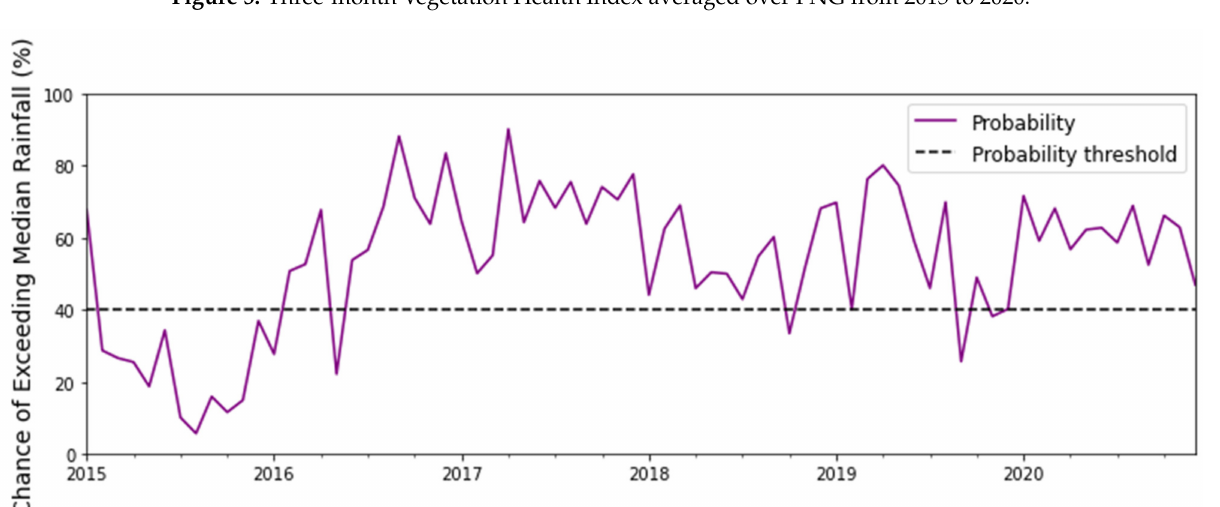
Figure 5. Three-month Vegetation Health Index averaged over PNG from 2015 to 2020.